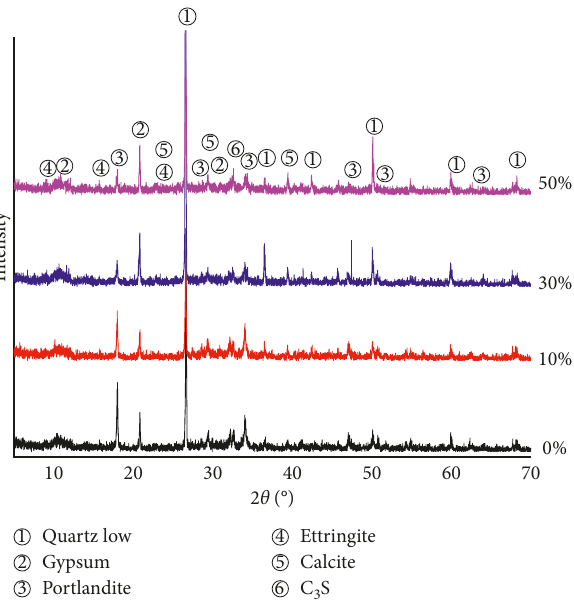
Figure 14: XRD patterns of mortars with different amounts at 28d